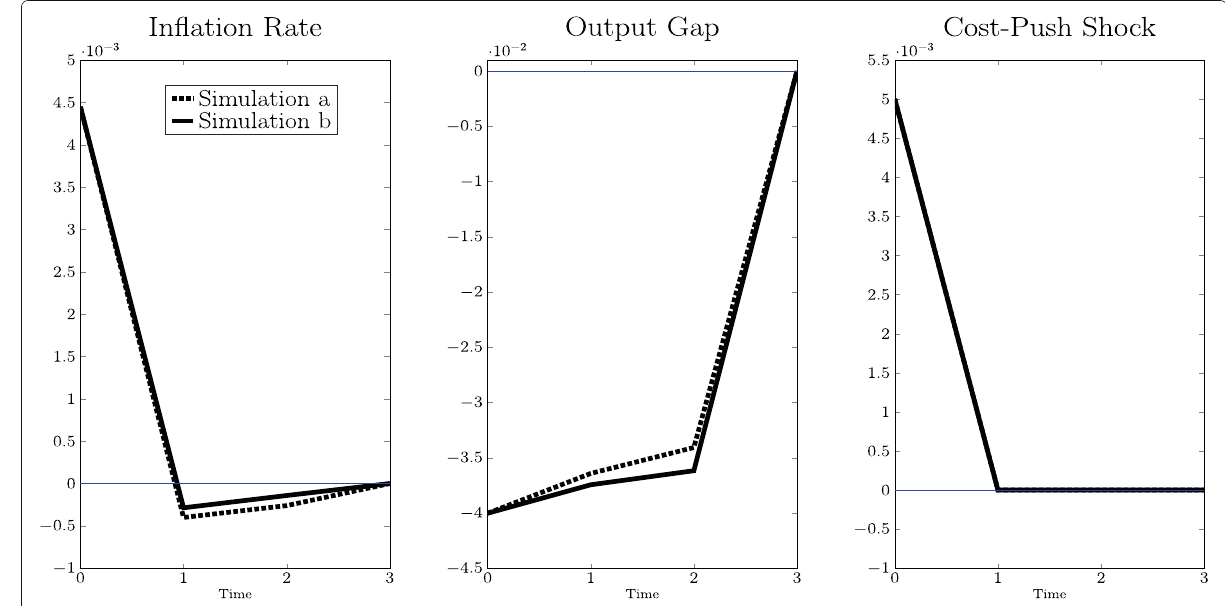
(cid:15) (cid:16) T + 1 γ a = { 1,1,1,0 } and simulation b (solid lines) assumes central bank credibilities t t = 0 } T + 1 = { H ,0,0,0 } and ρ = 0. To highlight the difference in the t u t = 0